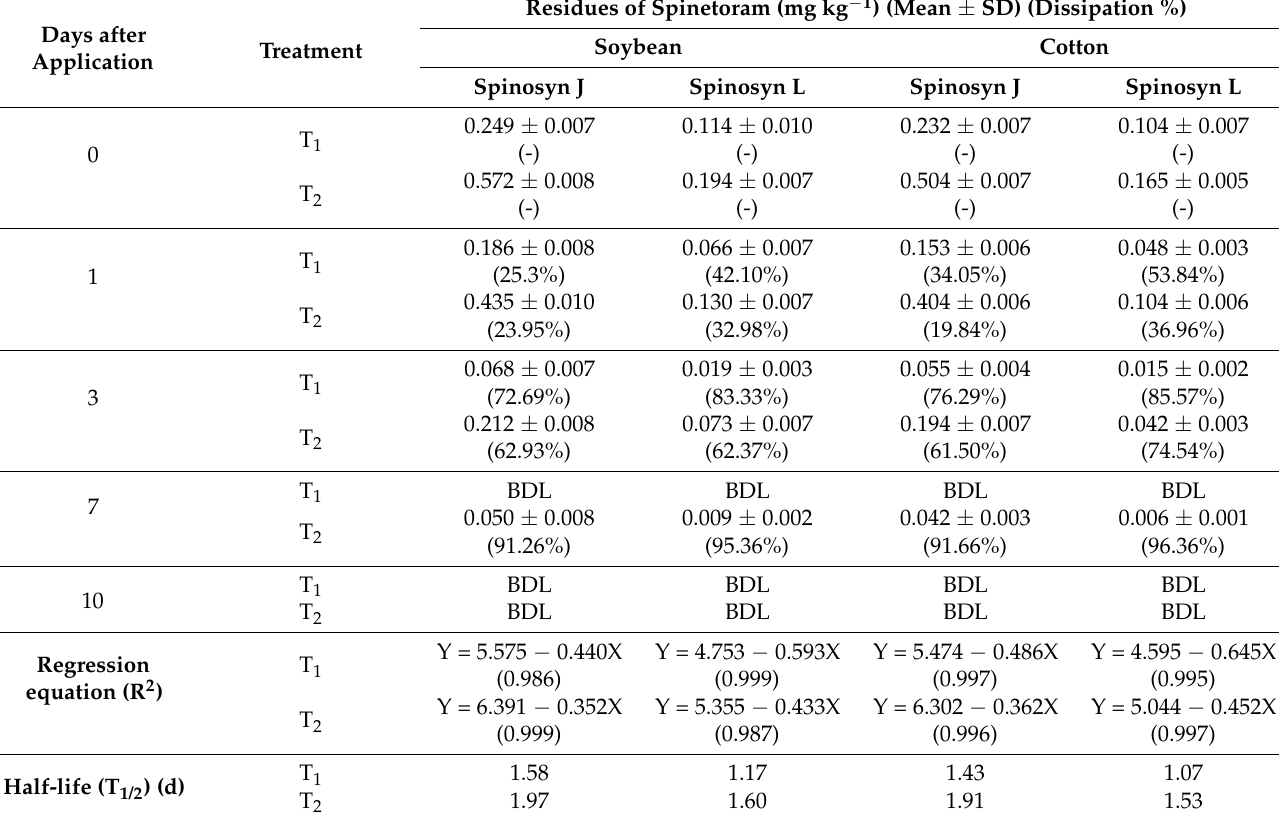
Table 3. Dissipation of spinetoram residue in soybean and